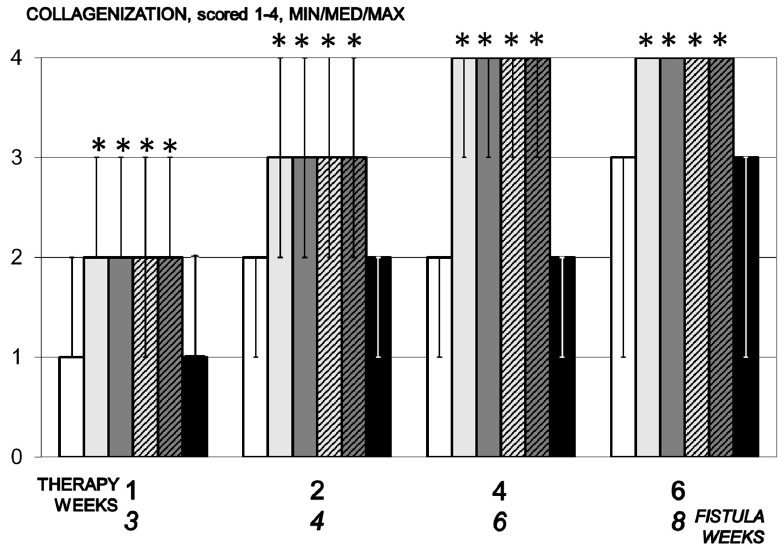
Figure 7. Collagenization, scored 1–4, Min/Med/Max, time line. Therapy regimens starting at the day 14 after fistula creation (therapy day 0), included BPC 157 given once daily intraperitoneally, last application at 24 h before sacrifice, 10 µ g/kg (light gray bars) or 10 ng/kg (dark gray bars) or given perorally, in drinking water 10 µ g/kg/day (dashed light gray bars) or 10 ng/kg (dashed dark gray bars) until the sacrifice. Controls received simultaneously an equal volume of saline (5 mL/kg) intraperitoneally (white bars) or drinking water (12 mL/rat/day) (black bars). * p < 0.05, relative to